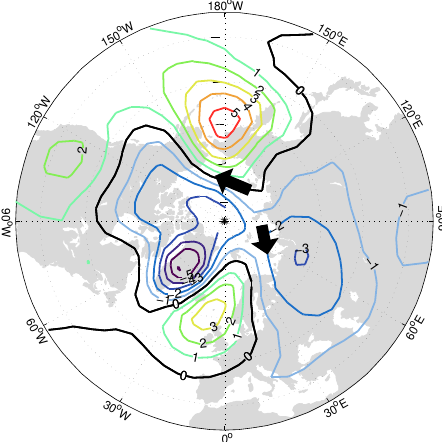
Figure 9. Difference between the geopotential height anomalies (in m) at 800hPa of LOVECLIM with sea ice data assimilation and LOVECLIM without data assimilation. The black arrows show the flow responsible for the change in sea ice at the Barents Sea and the Chukchi